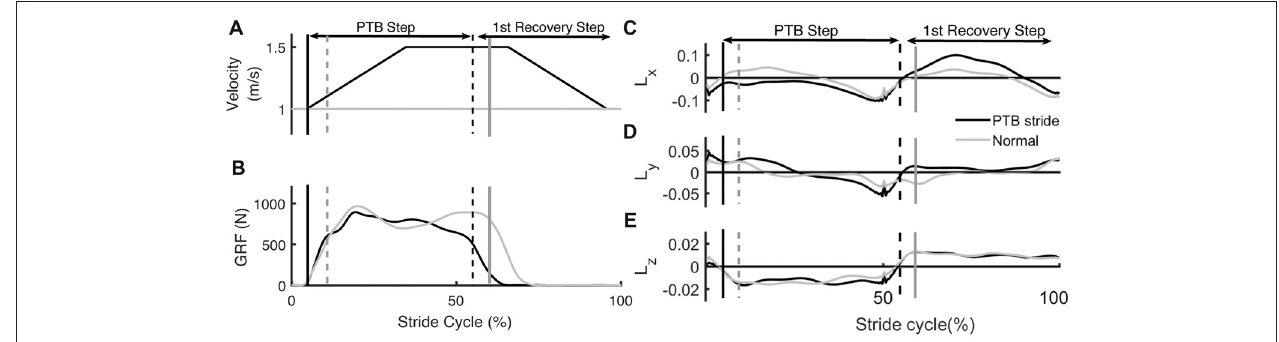
FIGURE 2 | Example of time series data from an unperturbed and perturbed step. (A) Treadmill belt velocity, (B) vertical ground reaction force and (C–E) whole-body angular momentum (WBAM) for a representative perturbation step and recovery stride. The gray traces indicate the time series data for an unperturbed stride while the black traces indicate a perturbation stride. Each stride begins at heel strike. Black vertical lines correspond to the time of foot strike and gray vertical lines correspond to time of toe-off. Solid lines and dashed lines represent contralateral legs.